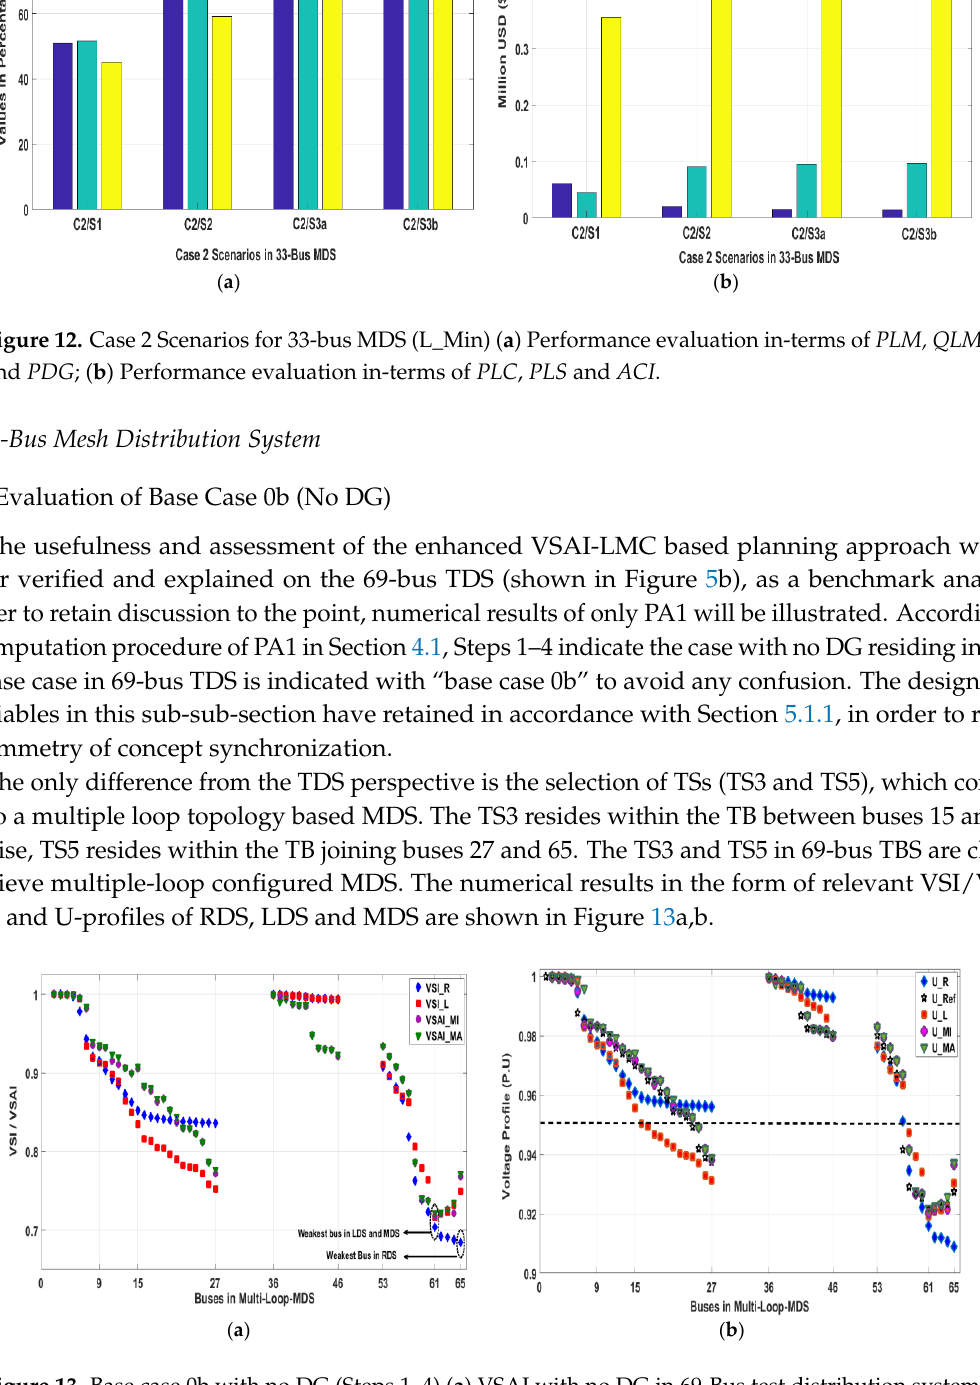
Figure 13. Base case 0b with no DG (Steps 1 – 4) ( a ) VSAI with no DG in 69-Bus test distribution system; ( b ) Voltage profile (U_Profile) with no DG in 69-Bus test distribution system.